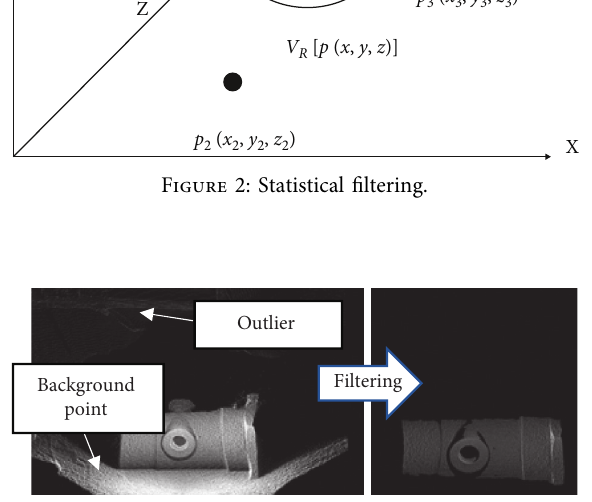
Figure 3: Point cloud image. (a) Before filtering; (b) after